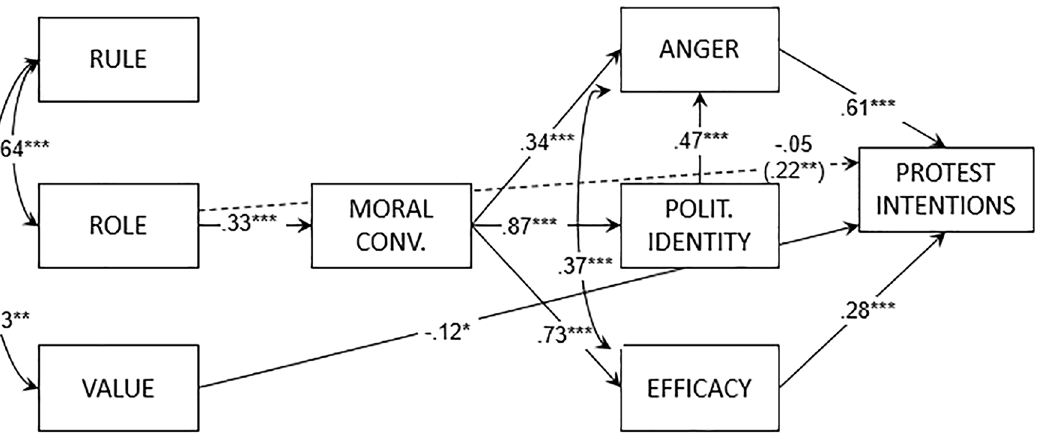
Figure 4. Path model of Study 3 (tradition-enhancing protest group). Note . Reported coefficients are standardized. In parentheses, the indirect effect from the orientation to protest intentions. Polit. =